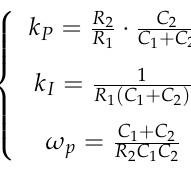
Figure 12. Circuit schematic diagram of the PI controller.